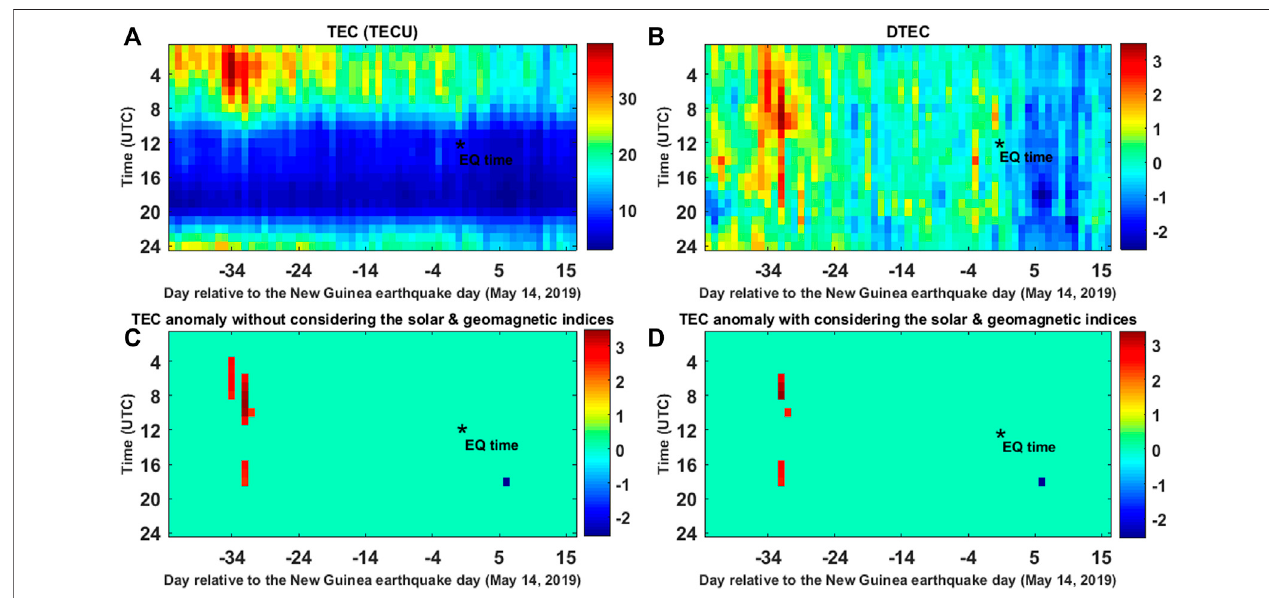
FIGURE 13 | Summary of TEC analysis results using median method for the Papua New Guinea (May 14, 2019) from April 01 to June 30, 2019. The y -axis represents the time UTC (LT = UTC − 5:00). (A) TEC variations, (B) DTEC variations calculated by formula of DTEC (cid:1) TEC − Median DTEC| = > 1.5, and (D) detected TEC anomalies when ap < 20 nT, Dst > − 20nT, Dst < 20 nT and F10.7 < 120, and ~|DTEC| = > 1.5.